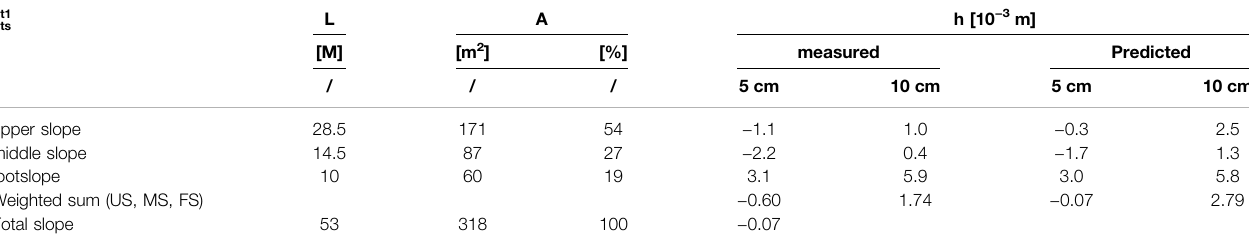
TABLE4| Slopelength(L)andarea(A)ofthedifferentslopesections(inm 2 and%ofthetotalslope)ofthetotalslopetogetherwithweightedchangesinaveragesoilsurface elevation (h) (according the share of each slope part of in the total slope) corrected by the measured and predicted soil bulk density ( Eq. 1 ) at the SfM-plots along the experimental slope between May 14 and 16 after correction for soil settlement; (cid:2) z t 1 ts denotes the applied correction value for the compaction depth of 5 and 10 cm; the weighted sum describes the average loss in soil elevation derived from the SfM-plots extrapolated to the total slope and weighted by the different area sizes. (cid:2) z t1